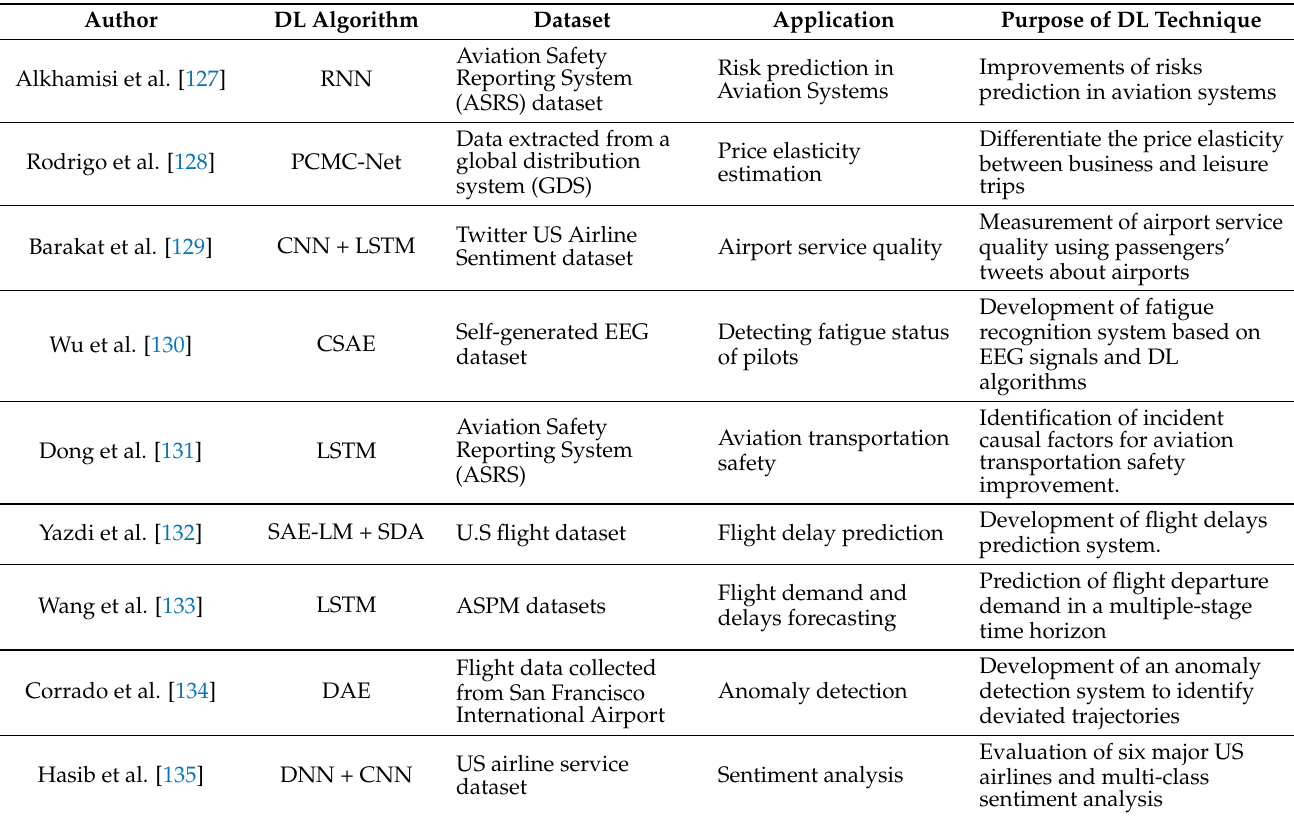
Figure 18. Applications of DL in aviation industry. Table 7. State-of-the-art contributions in DL-based aviation